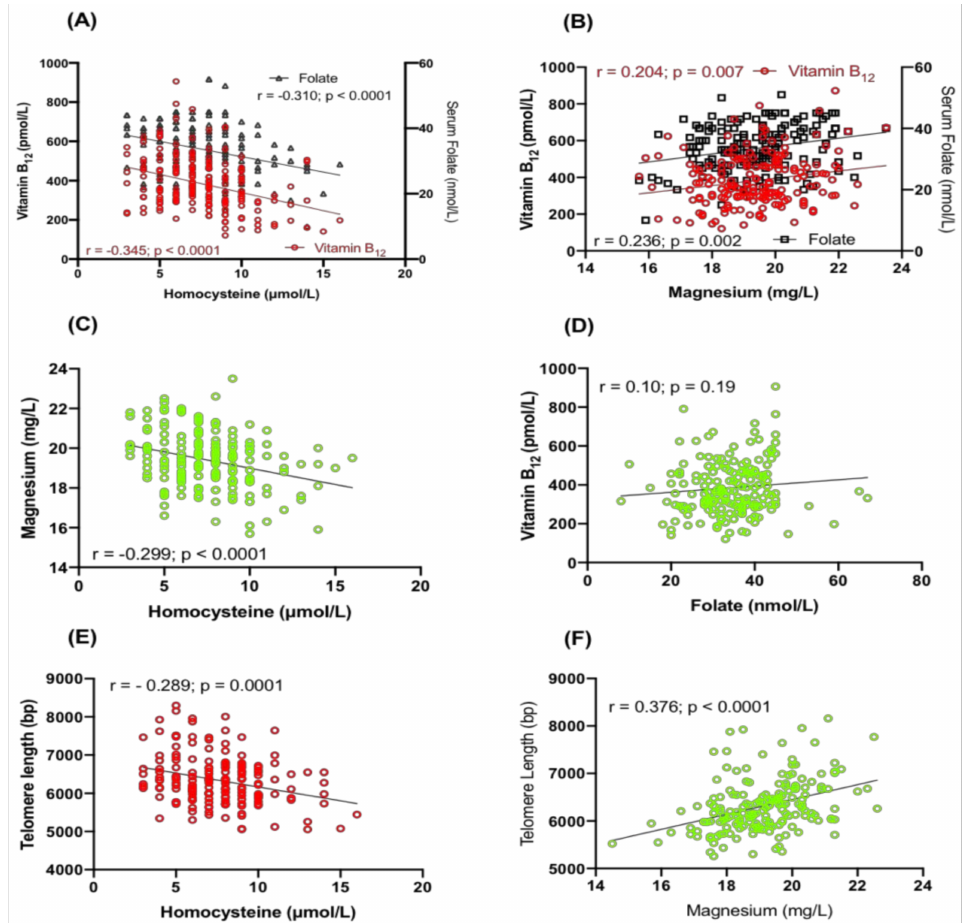
Figure 2. ( A ) The correlation of vitamin B 12 (left panel) and serum folate (right panel) with homo- cysteine; ( B ) correlation of vitamin B 12 (left panel) and serum folate (right panel) with magnesium; ( C ) correlation of magnesium with homocysteine; ( D ) correlation of vitamin B 12 with serum fo- late; ( E ) correlation of telomere length with homocysteine, and ( F ) correlation of telomere length with